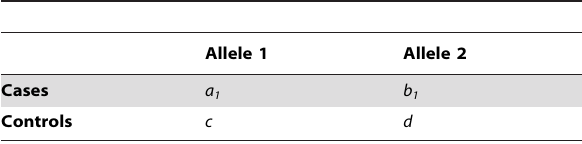
Table 2. 2 6 2 contingency table of allele counts given the presence of a subclass.